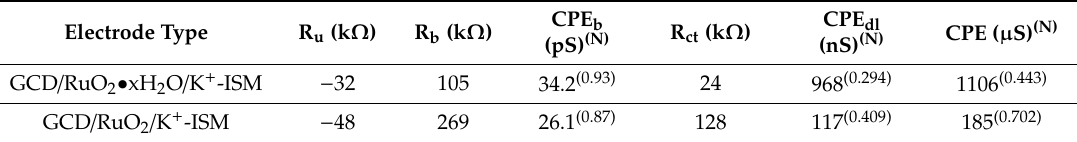
Table 3. Electrical parameters of studied electrodes.